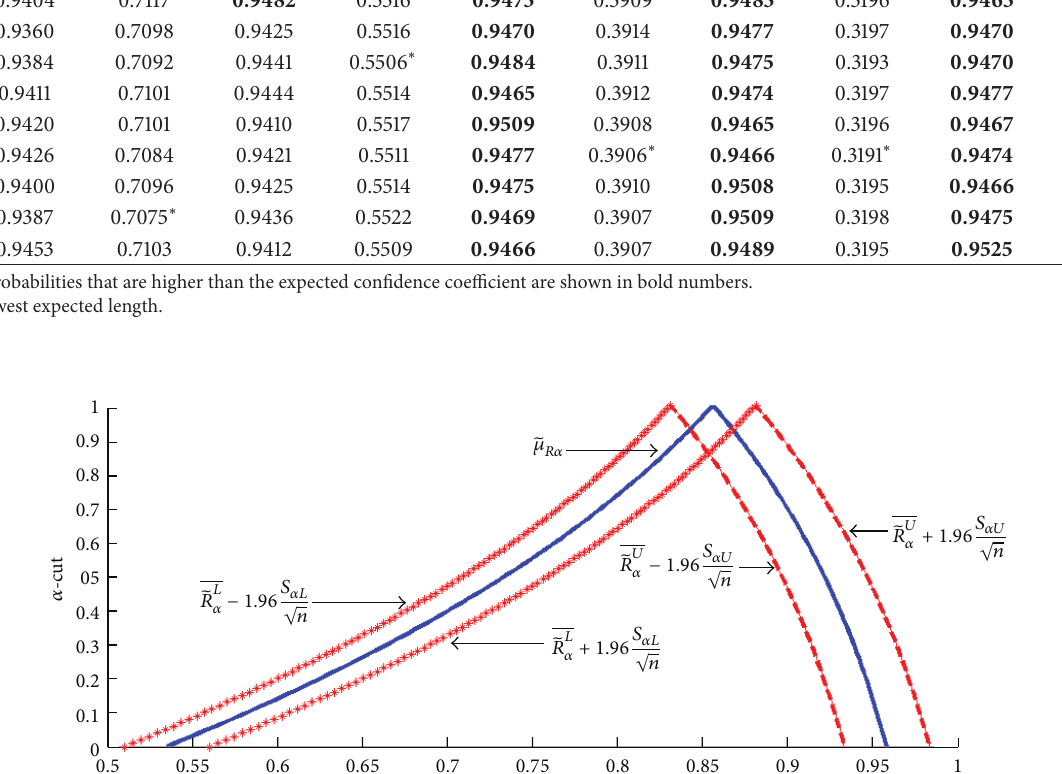
Table 4: Upper fuzzy coverage probabilities and upper expected lengths for 95% confidence interval where 𝑚 = 10 , 000 and